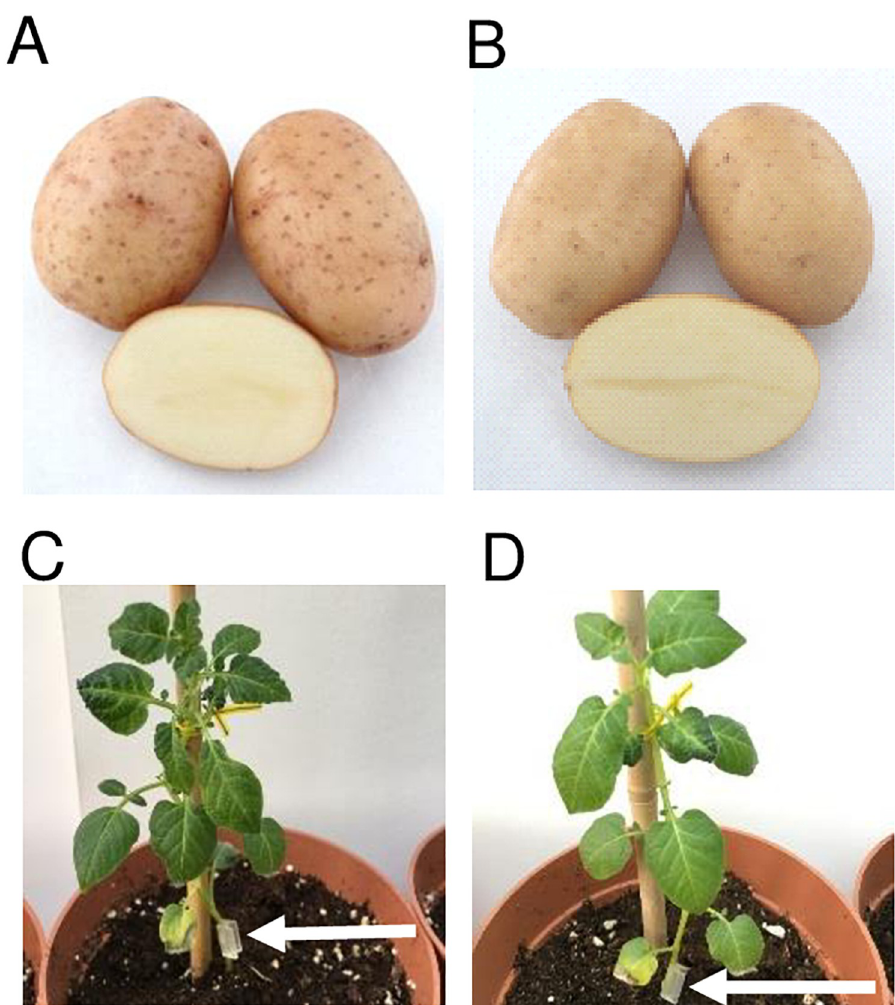
Fig 1. Tuber and canopy morphology of two Hungarian potato cultivars, Ho´pehely (A and C) and White Lady (B and D). Tubers were grown in field conditions (photography by Z. Polga´r). The canopy morphology of the greenhouse-grown plants is shown. Four-week-old in vitro plants were potted and used for grafting experiments two weeks after potting. The arrows indicate the scion/stock junctions.